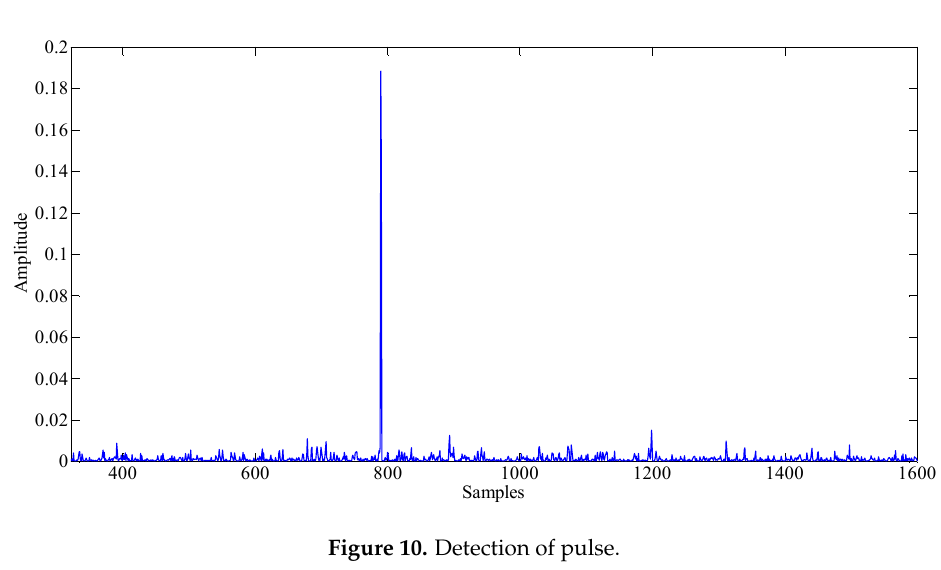
Table 5. Parameter identification of Equation (21).